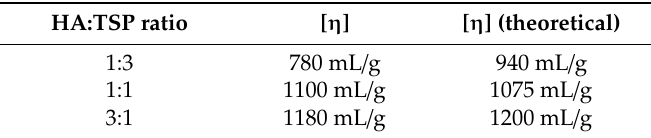
Table 2. Measured intrinsic viscosities for HA:TSP mixtures compared with the theoretically predicted (based on values from Table 1) if there was no